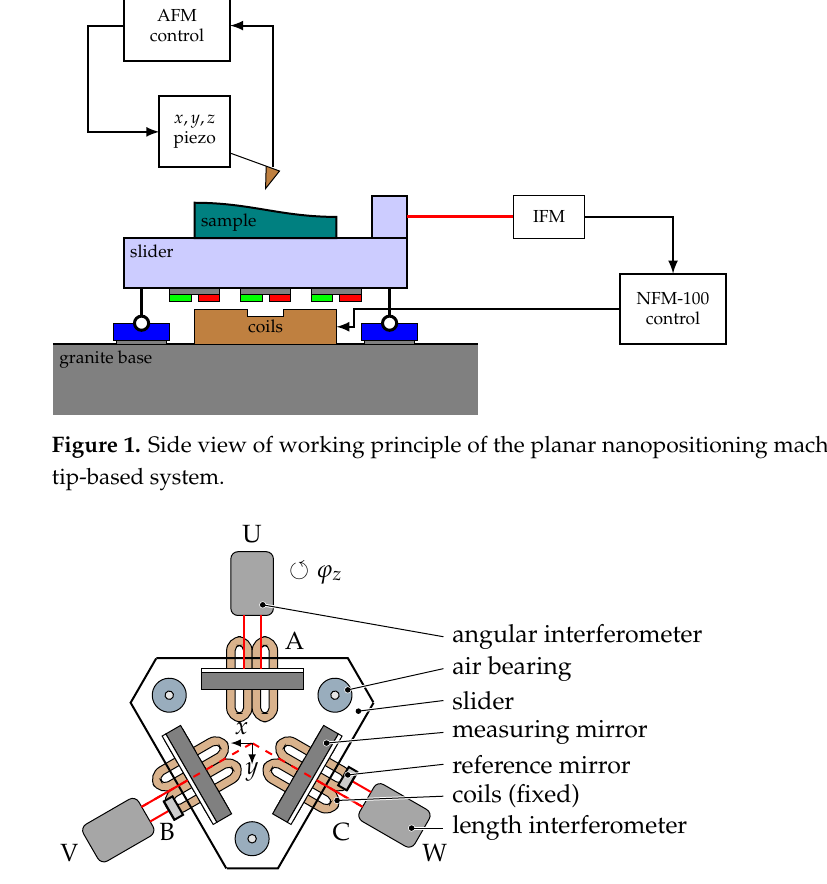
Figure 2. Mechanical and interferometer set-up of the NFM-100. The position of the slider is tracked by three laser-interferometers in a 120° arrangement. The slider is driven by three linear actuators, which consist of two flat coils and a magnet array each (magnet array not shown here). (Figure leaned on